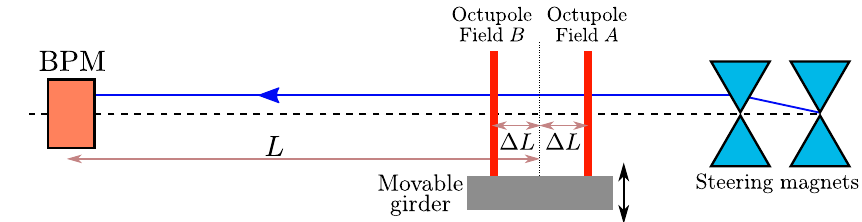
FIG. 3. Aligning the beam in two accelerating structures both with octupole